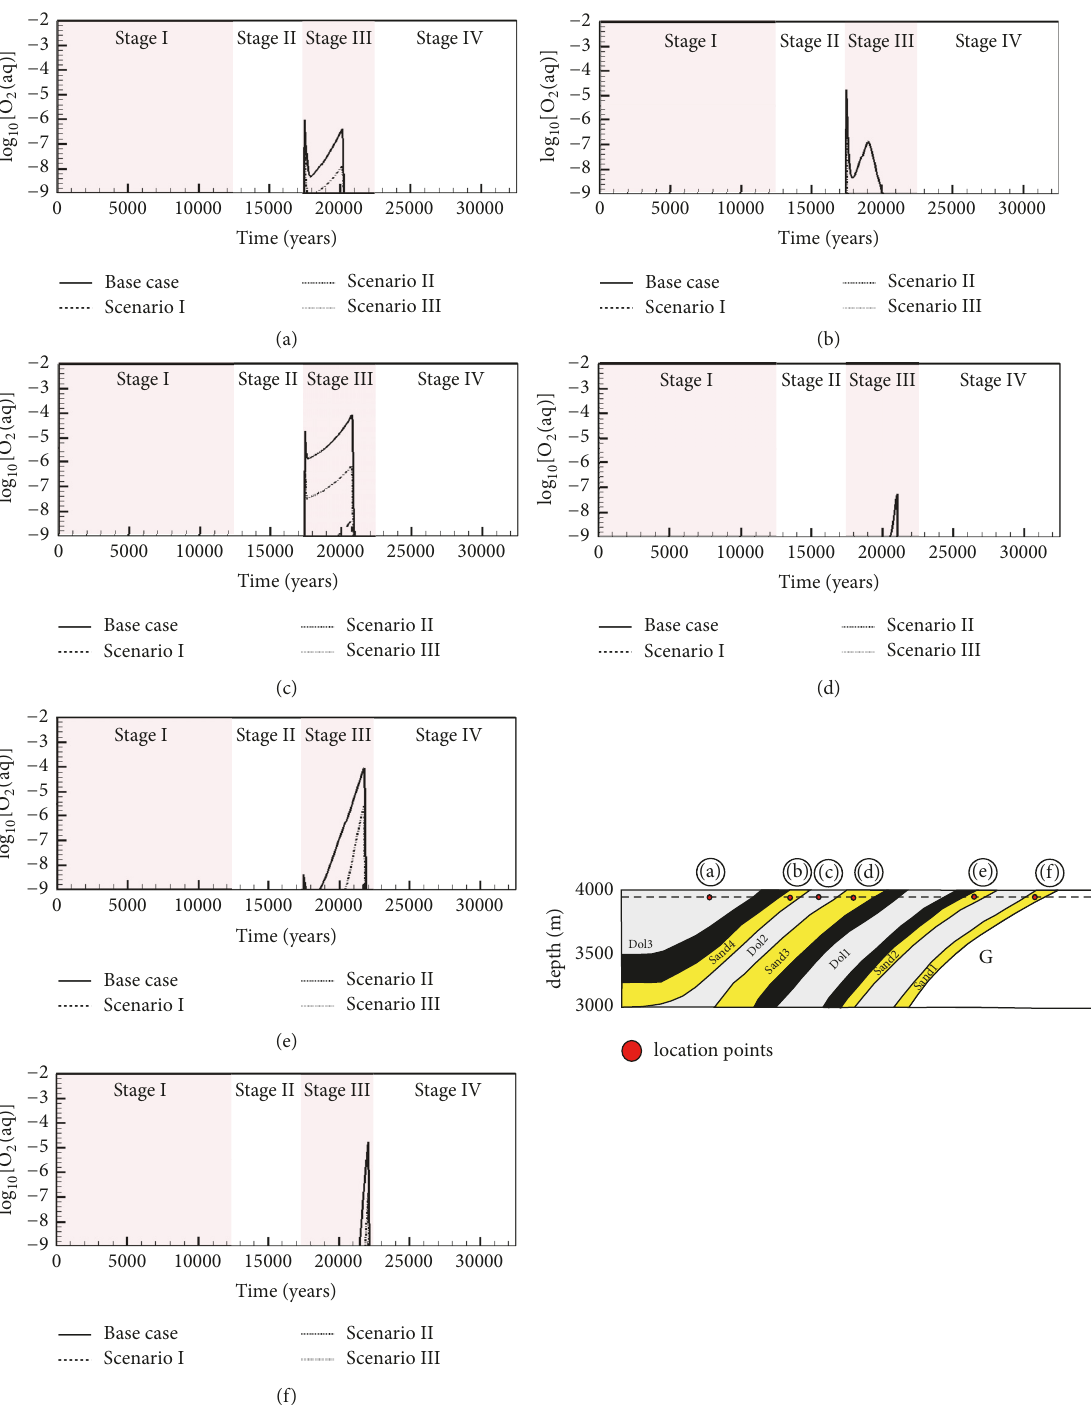
Figure 10: Temporal evolution of dissolved O 2 concentrations at a depth of 75 m comparing results from Scenarios I–III to the results of the base case. (a), (b), (c), (d), (e), and (f) for Dol3, Sand4, Dol2, Sand3, Sand2, and Sand1, respectively. O 2 concentrations in moll −1 . If O 2 profiles are not visible for a specific unit, concentrations remain below 1 × 10 −9 moll −1 for duration of simulation.